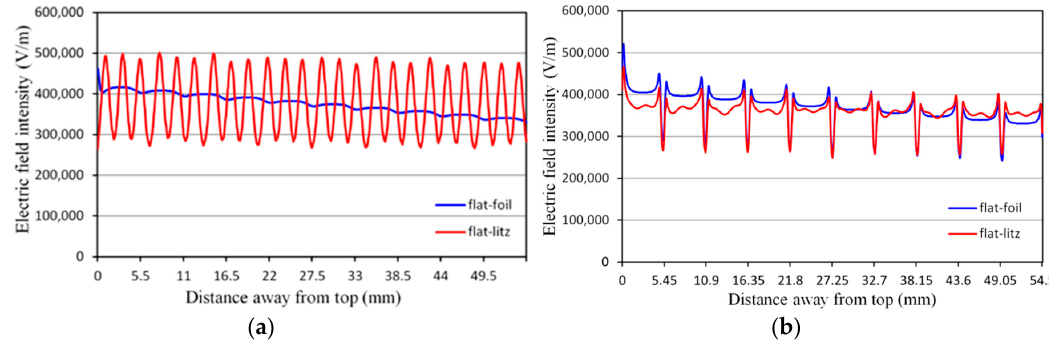
Figure 7. Electric field intensities on path 1 and path 2 for winding N-1 (flat-foil) and winding N-4 (flat-litz): ( a ) Electric field intensities on path 1; ( b ) Electric field intensities on path 2.